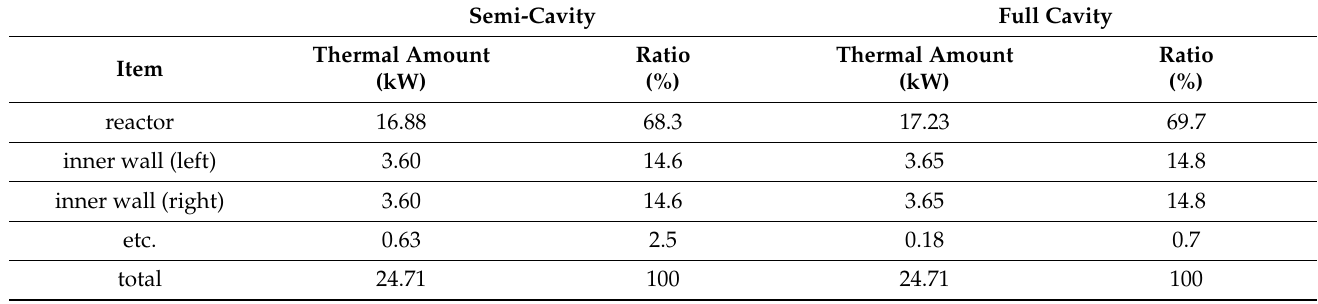
Table 3. Concentrated heat amounts according to location in the cavity. Semi-Cavity Full Cavity